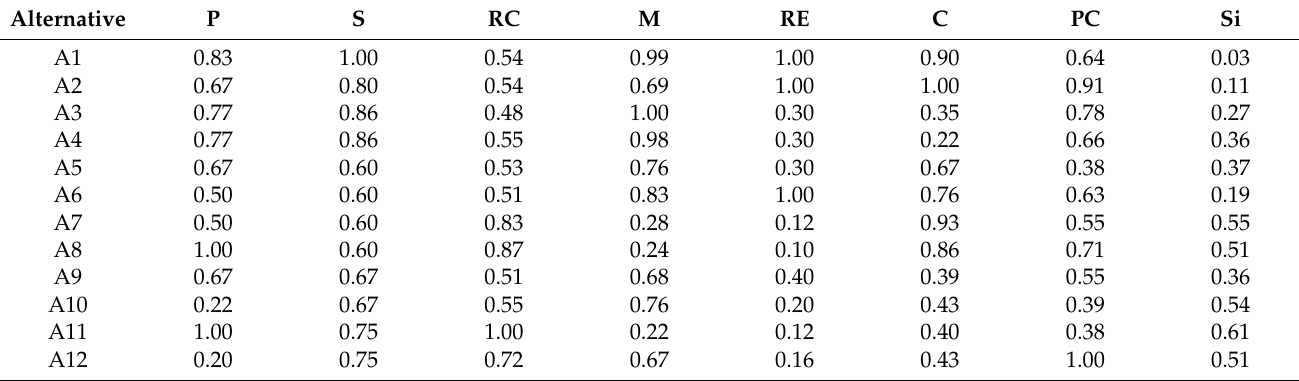
Table 2. Calculations of the performance values of alternatives using